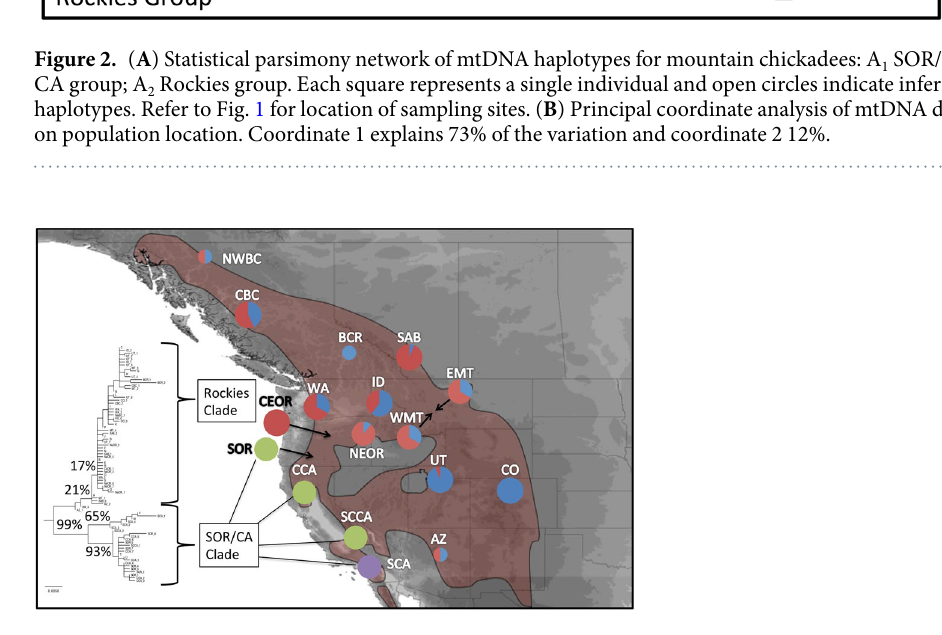
Among Rocky Mountain populations 24 of 45 F ST comparisons were significant, Idaho was significantly different from all populations, and northeast Oregon from all populations except southern Alberta and Utah, Central Oregon from all populations except southern Alberta, eastern and western Montana, and Colorado, and central British Columbia from all but three populations (southern Alberta, western Montana and eastern Montana).